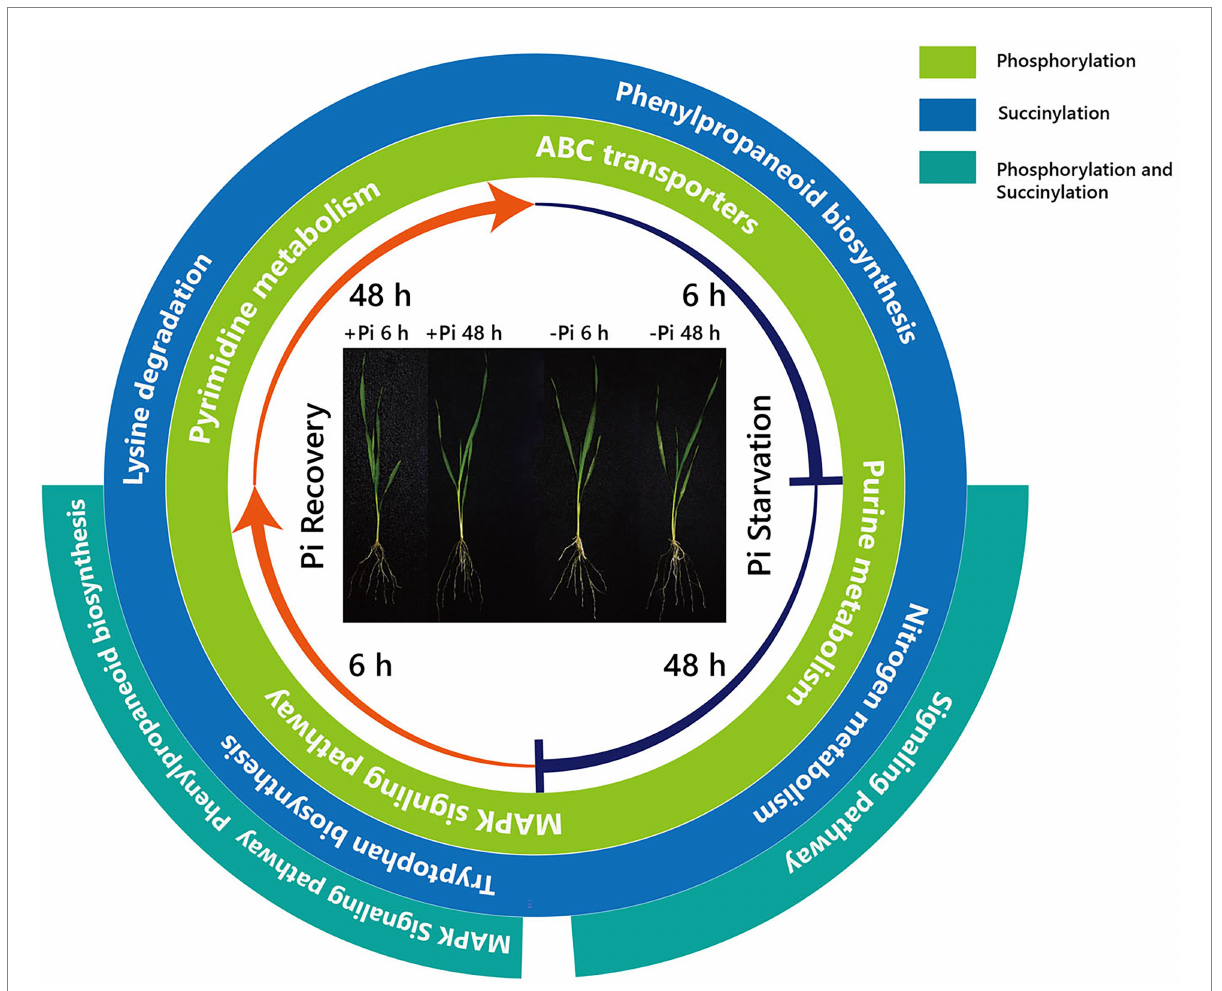
FIGURE 9 Summary of KEGG pathways of phosphorylated and succinylated proteins in response to Pi starvation and recovery. From the inside, the first and second circles show pathways overlapping the response of phosphorylation and succinylation proteins to Pi deficiency and recovery, respectively. The third circle shows pathways overlapping between the response of phosphorylation and succinylation proteins to deficiency and recovery. –Pi, Pi starvation; +Pi, Pi recovery. KEGG, Kyoto Encyclopedia of Genes and Genomes; Pi, intracellular